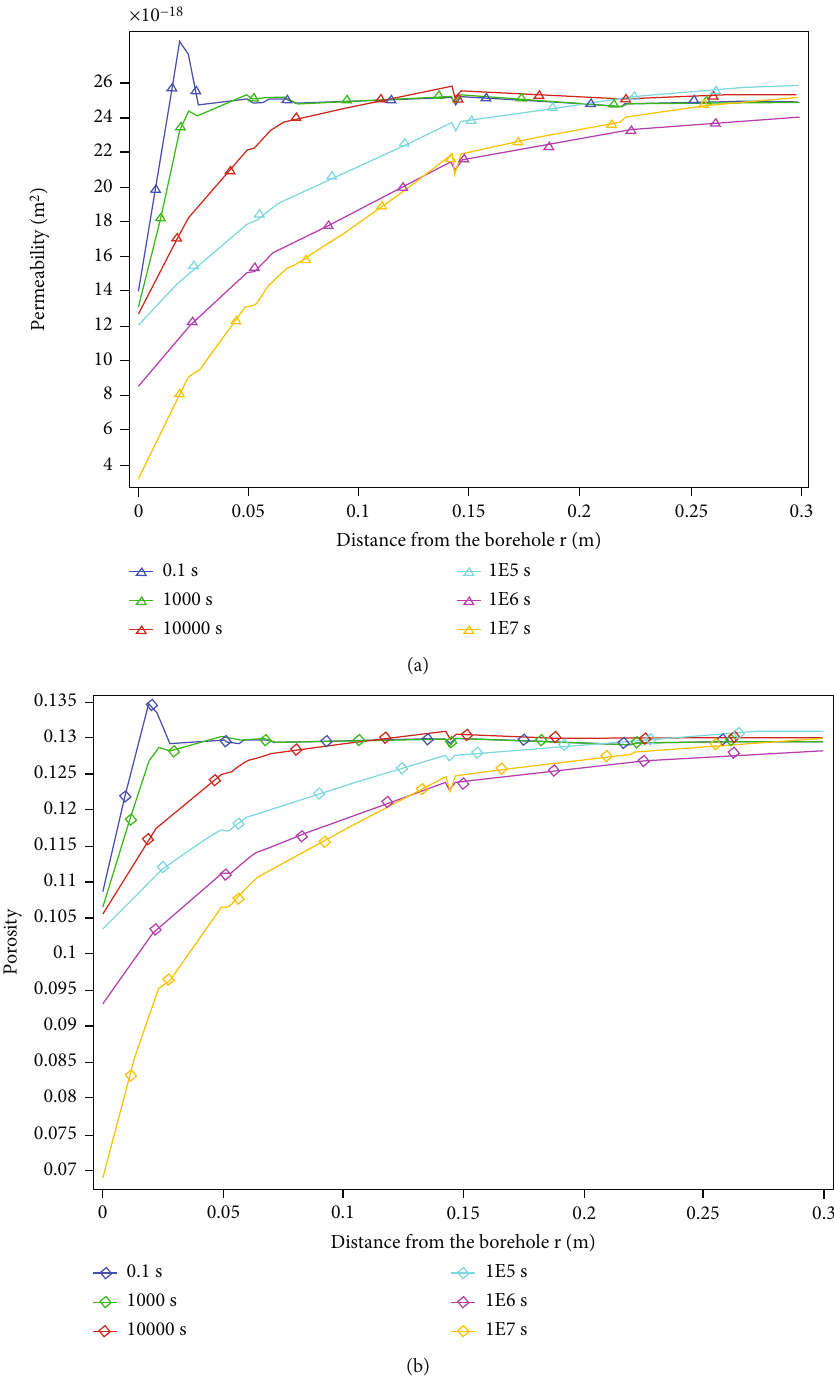
Figure 10: Gas permeability (a) and porosity (b) in the homogeneous coal rock during CBM